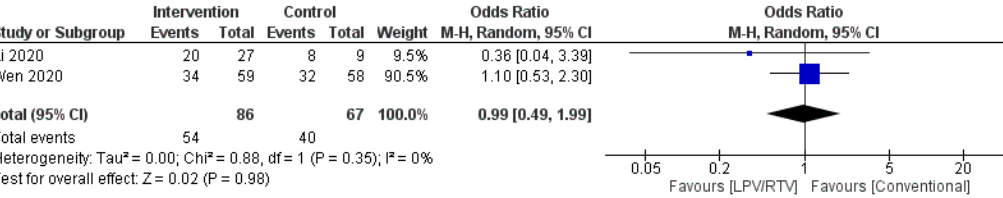
Figure 7. Rate of cough alleviation after 7 days of treatment (LPV/RTV vs. umifenovir). CI, confidence interval; df, degrees of freedom; LPV/RTV, lopinavir/ritonavir.